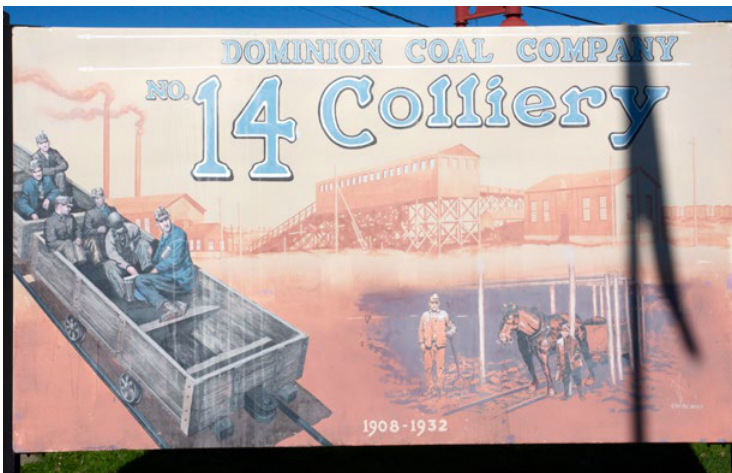
Figure 5. Number 14 colliery